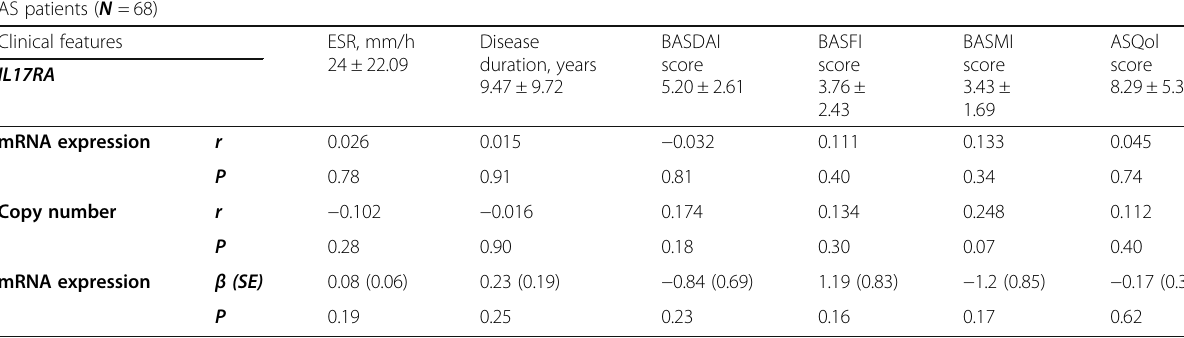
Table 5 Associations between mRNA expression and copy number of IL17RA with clinical features of AS AS patients ( N = 68) Clinical